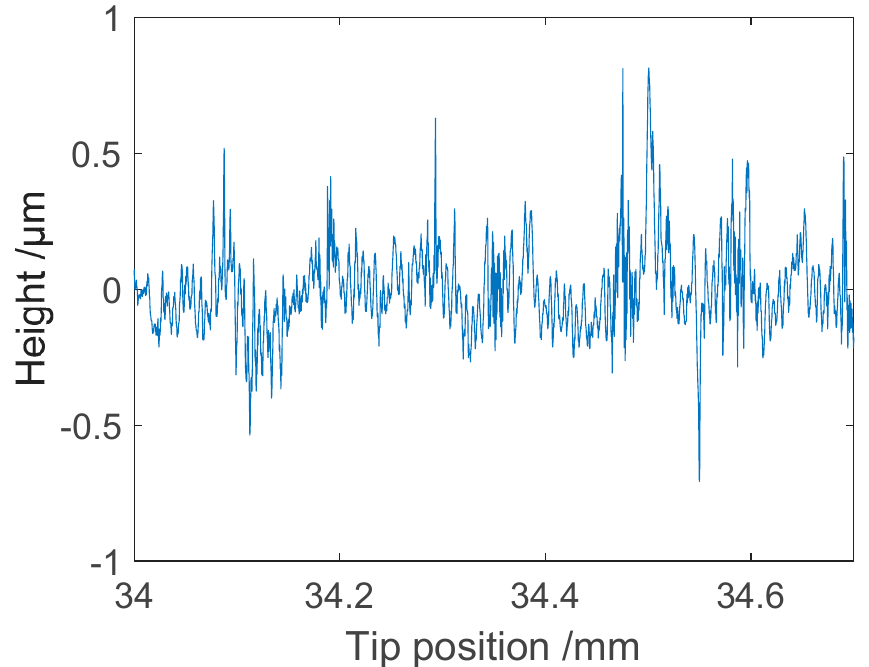
Figure 13. Difference between two consecutive measured profiles.